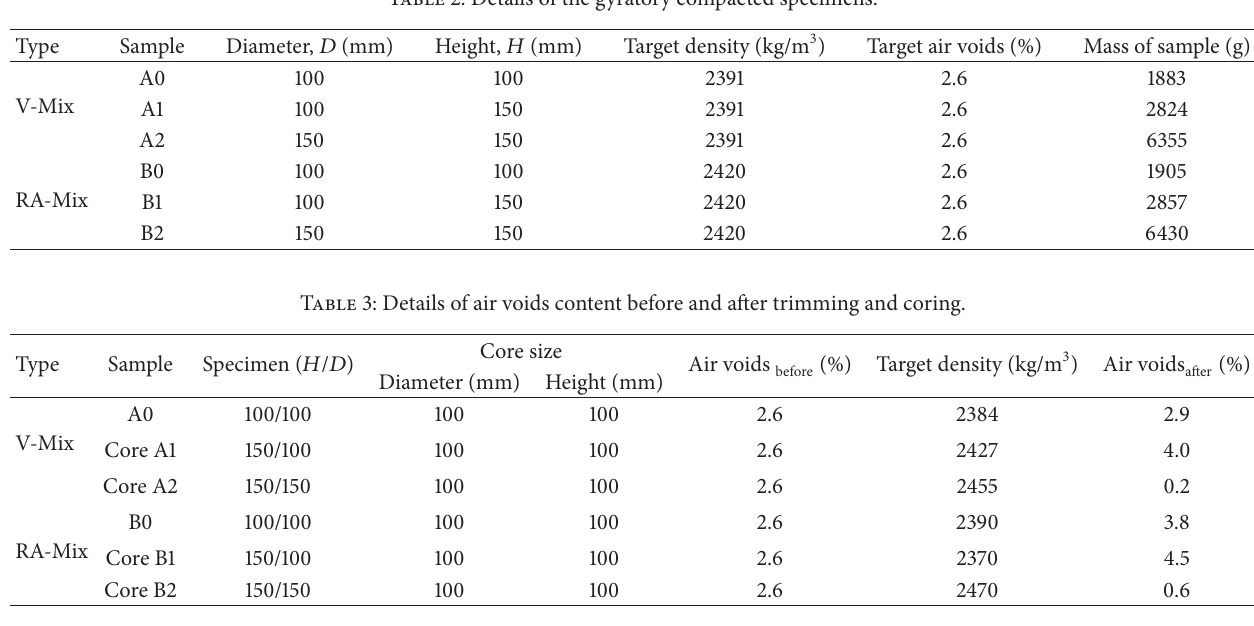
Table 2: Details of the gyratory compacted specimens.